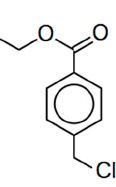
Figure 7. Structure of ethyl 4-(chloromethyl)benzoate.